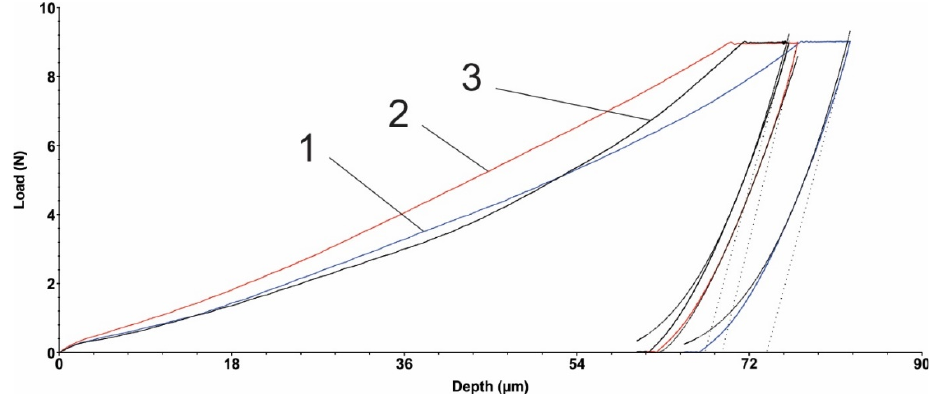
Figure 6. Hexagonal texture microindentation test (4 passes): 1, 2, 3—measurements.